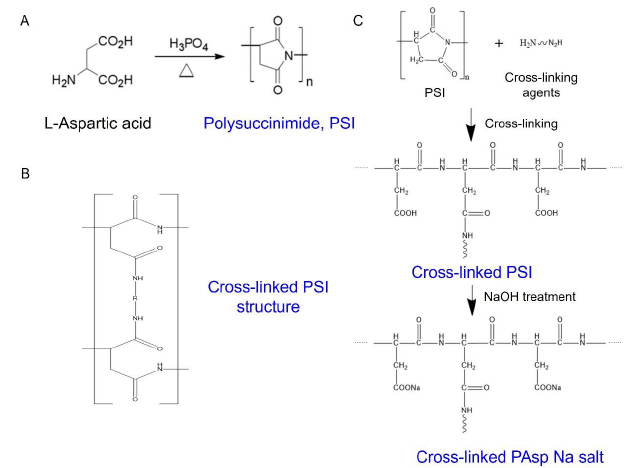
Figure 1. ( A ) Reaction scheme for PSI preparation, ( B ) chemical structure of cross-links in PSI, ( C ) cross-linking of PSI and subsequent hydrolysis to prepare PAspNa.